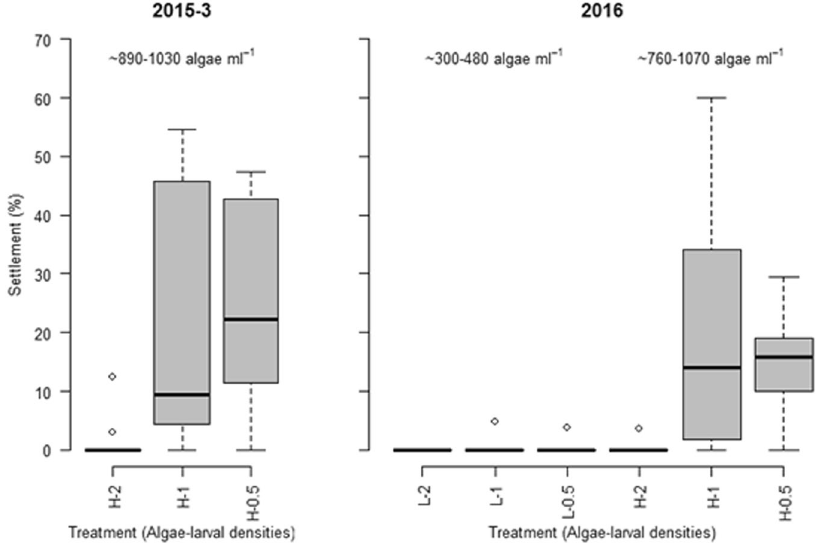
Figure 5. The percentage of larvae settling in different treatment conditions at the end of experiment 3 in 2015 and 2016. Well plates were used for settlement (n = 12 wells, except for the high chlorophyll treatment in experiment 3 in 2015 where n =